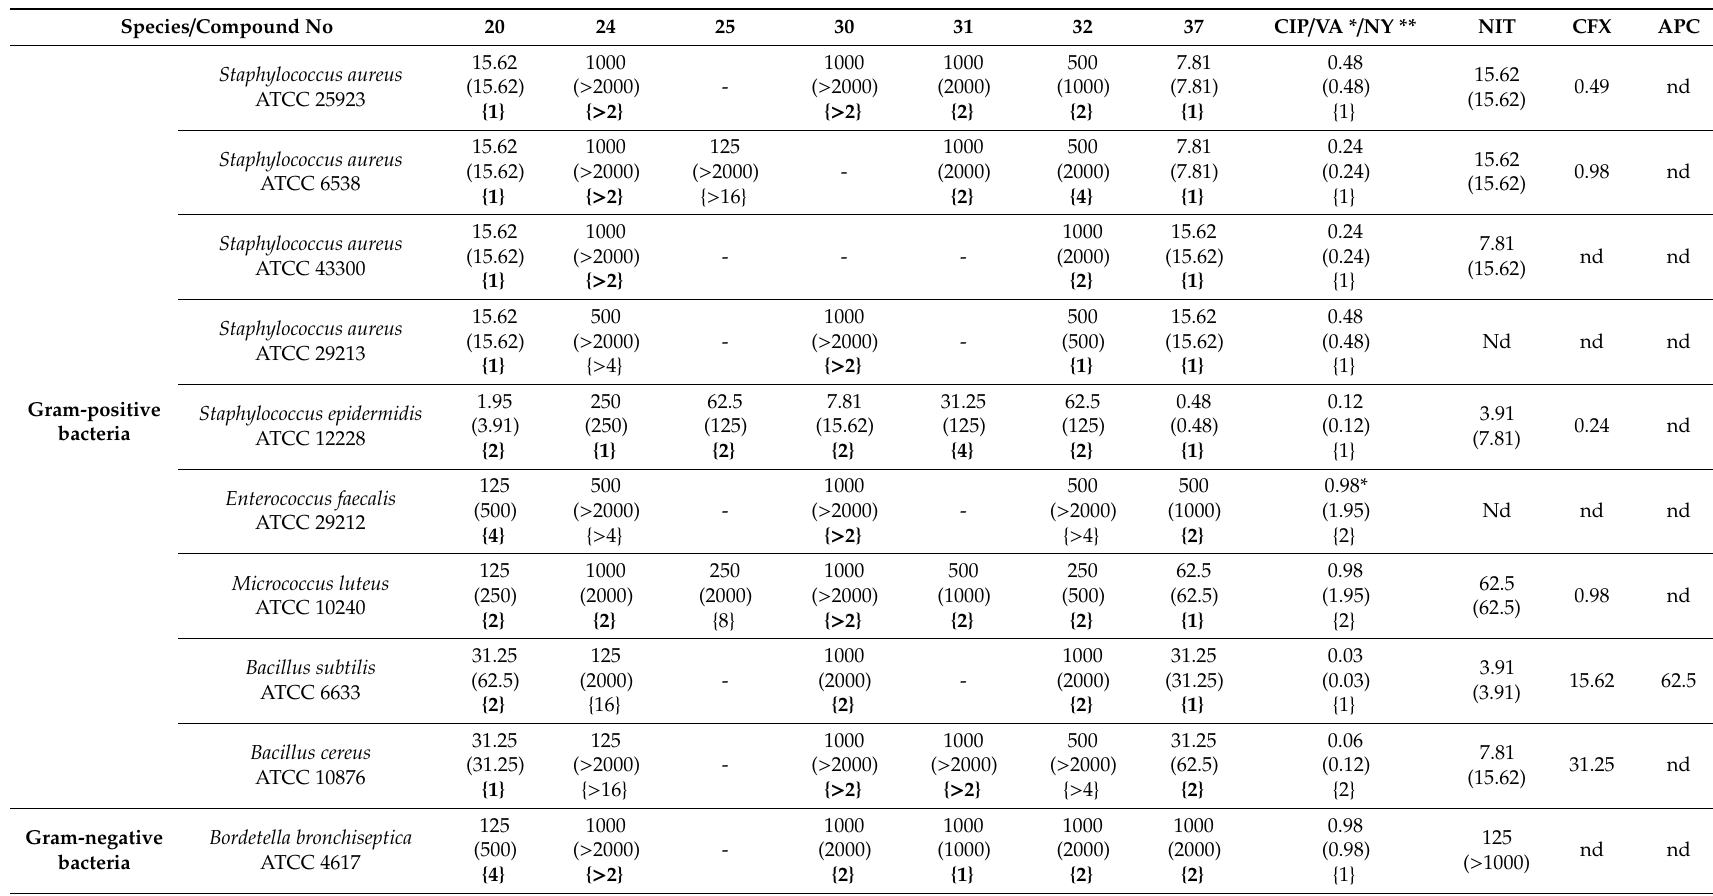
Table 2. The best active compounds 20 – 37 expressed as MIC (MBC or MFC) ( µ g / mL) and (MBC / MIC or MFC / MIC) values against the reference strains of microorganisms. Species / Compound